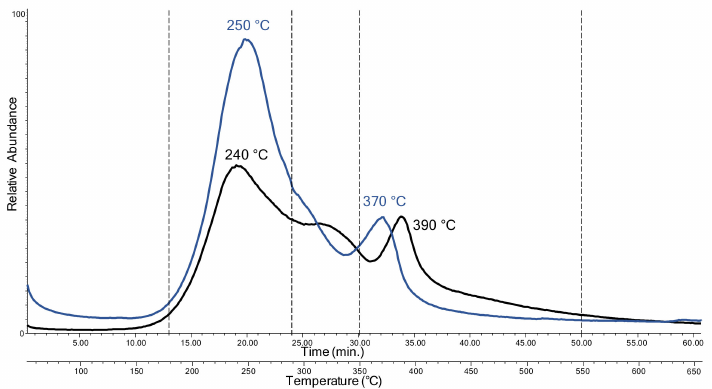
Figure 2. The evolved gas analysis coupled with mass spectrometry (EGA-MS) curves obtained for the samples from “Angel Lamp”: the sample from the side of the lamp (black), and the one from the head of the lamp